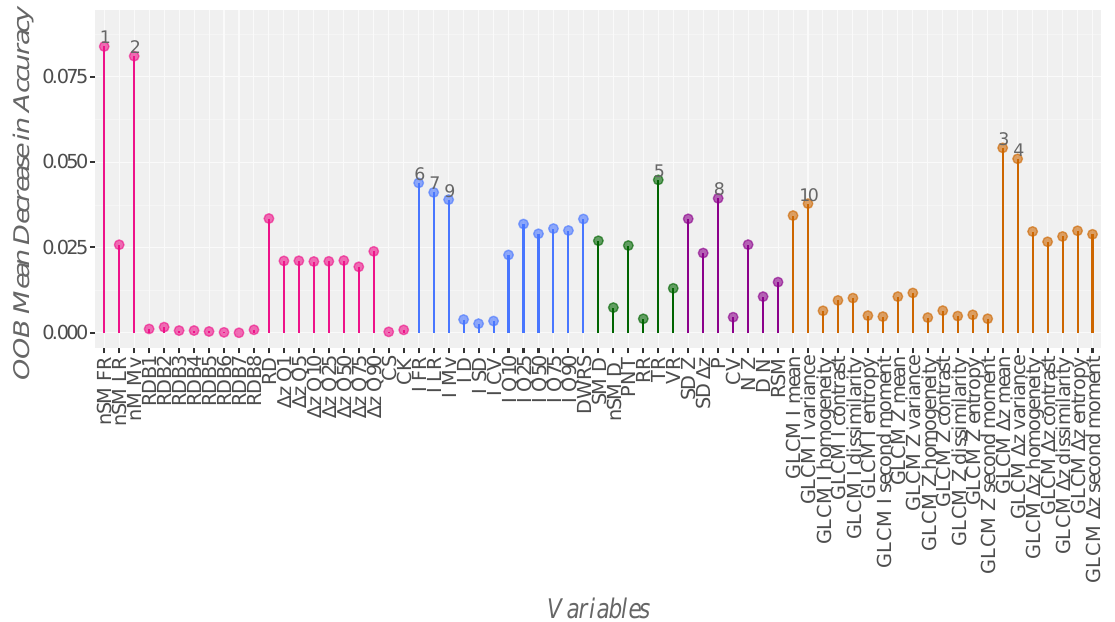
Figure 7. Importance of variables on a global context determined using RF from original LiDAR point cloud. E OOB = 13.0%. Elevation/height variables are shown in magenta, intensity variables in blue, return variables in green, roughness variables in purple and texture variables in orange.